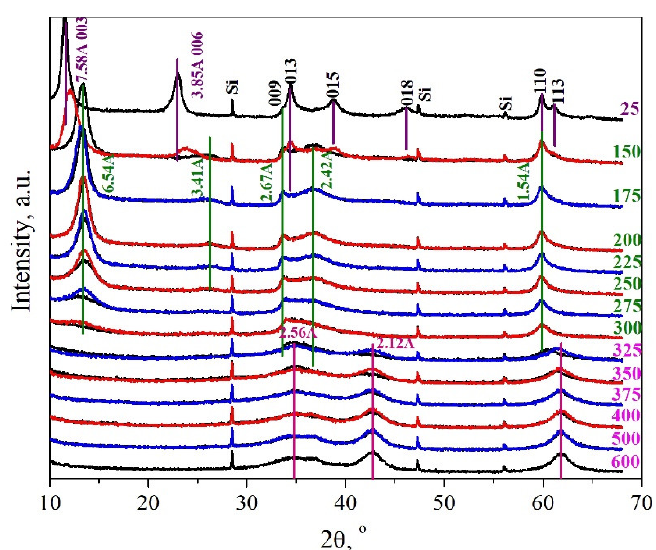
Figure 3. XRD patterns of MgGa-CO 3 LDH (Mg 2+ = 0.67) recorded in situ at different temperatures (the first record is shown by black line, while the second record is shown by red or blue color).